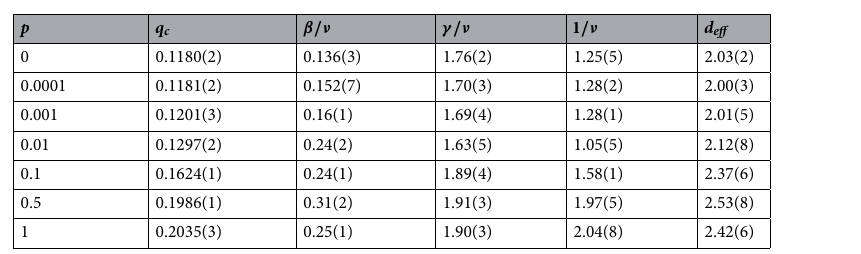
Table 2. Table of critical noise parameters q c , their correspondent critical exponents β/ν , γ/ν , and 1 /ν , and the effective dimension of the system d eff for the three-state majority-vote model on small-world networks for different rewiring probabilities p .